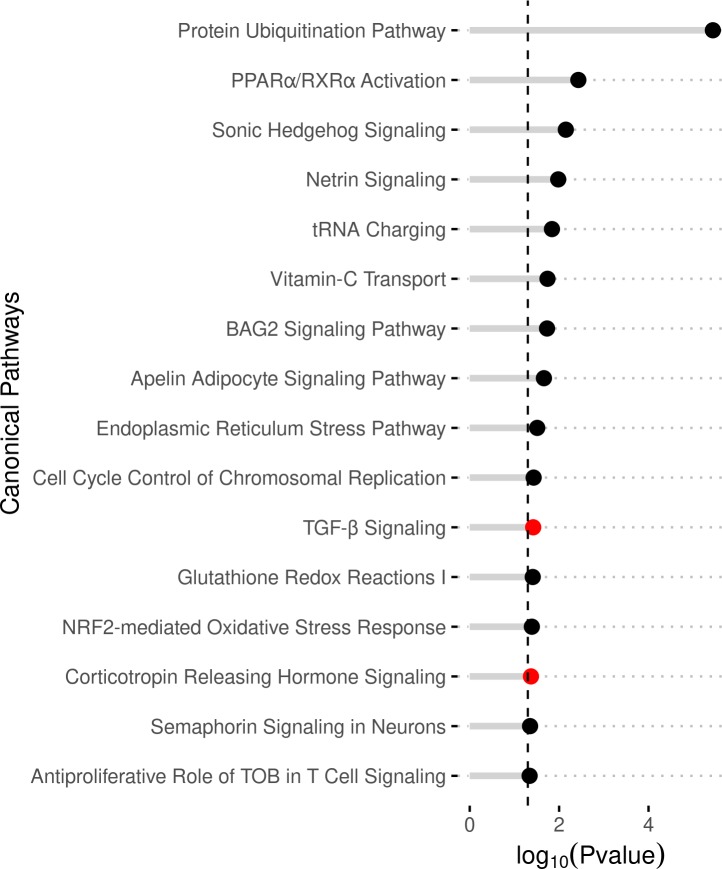
IPA canonical pathway analysis of DEGs.The enriched pathways are given on the y-axis. The x-axis represents the significance (negative Log of P-value). The color of the dots indicated level of significant z-score: black: |z|<1.96, red/activated: z>1.96, blue/inhibited: z<1.96.